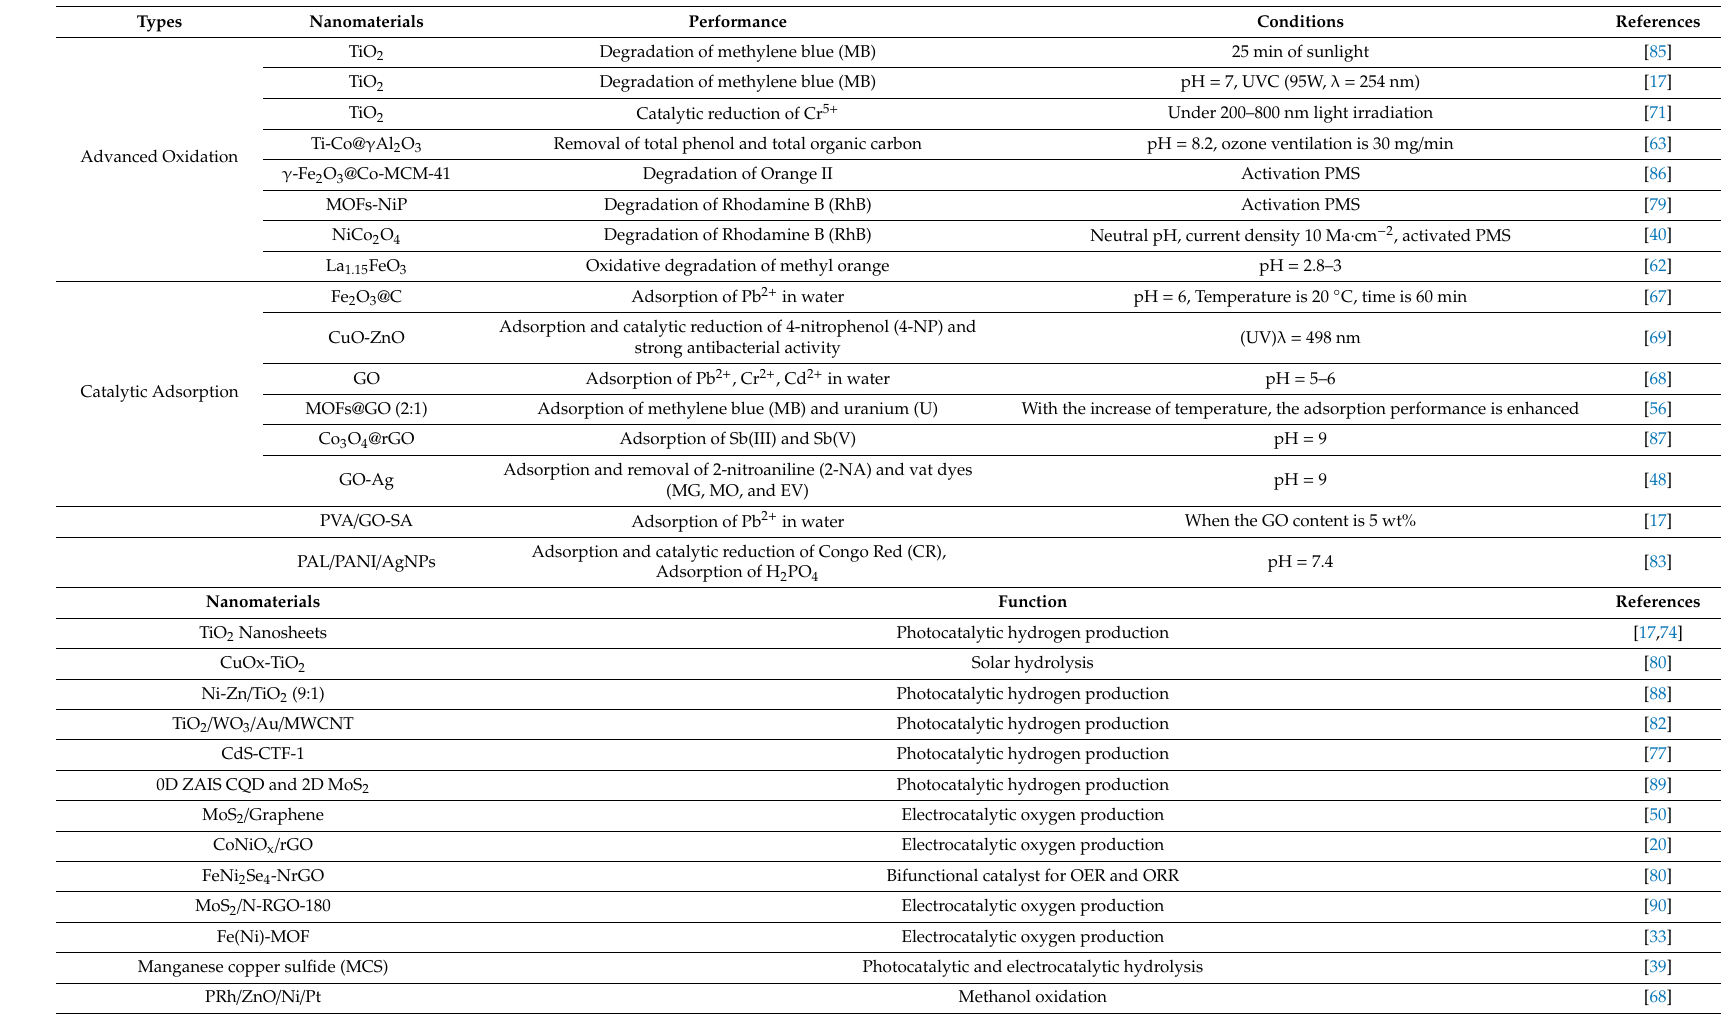
Table 4. Water-related nanomaterials of water environment problems and treatment